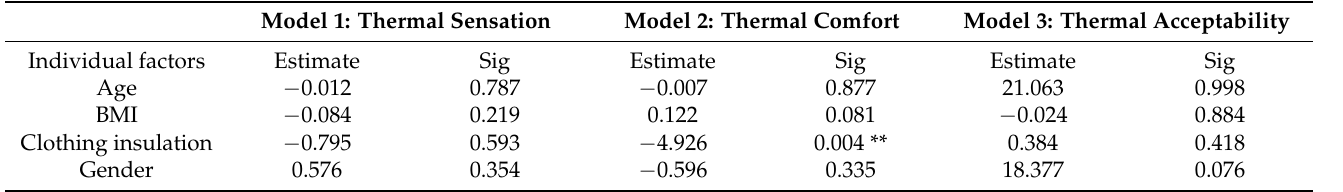
Table 4. Ordinal logistic regression model regression